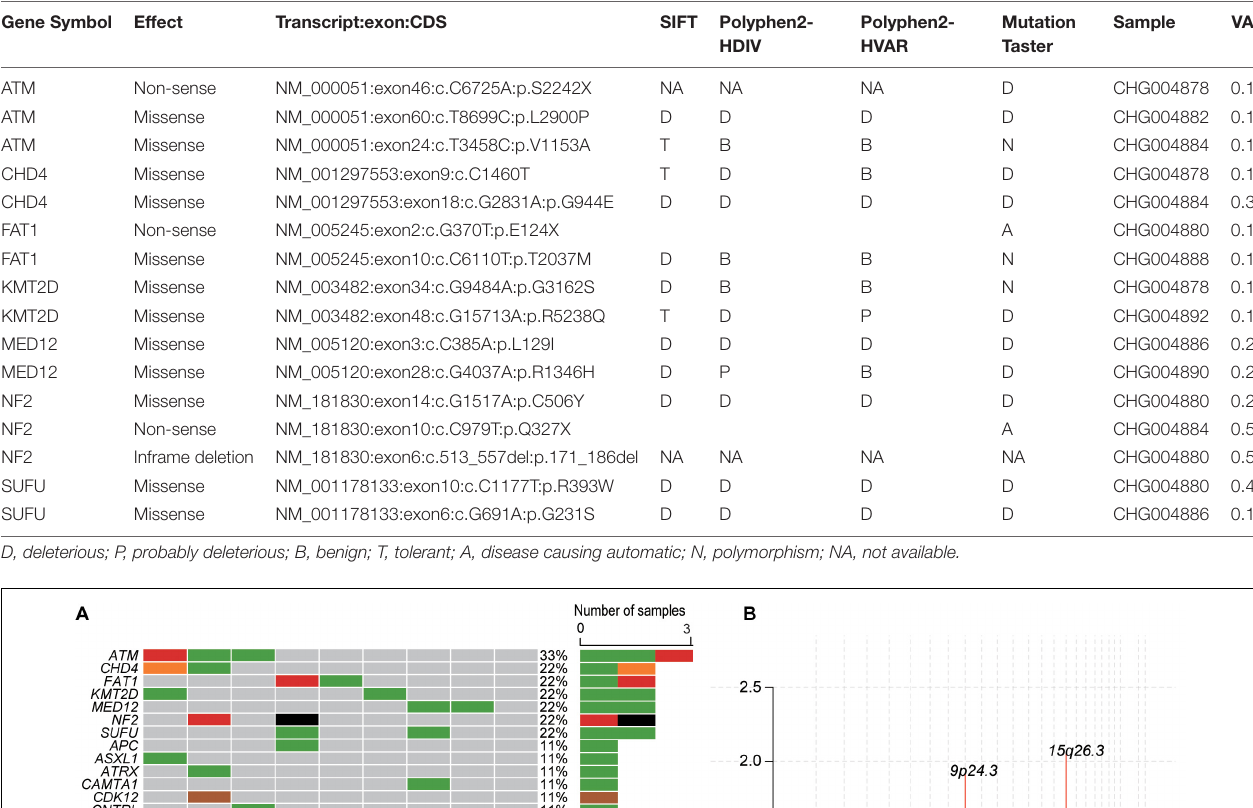
TABLE 2 | The pathogenicity of the somatic mutations in spinal schwannoma by SIFT, PolyPhen-2, and MutationTaster.